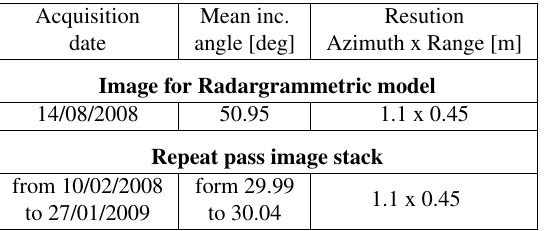
Table 1: Berlin TSX test site images features